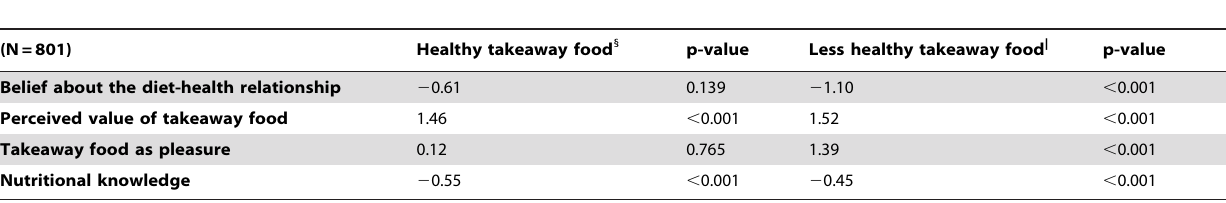
Table 4. Associations between psychosocial factors and takeaway food consumption { , `